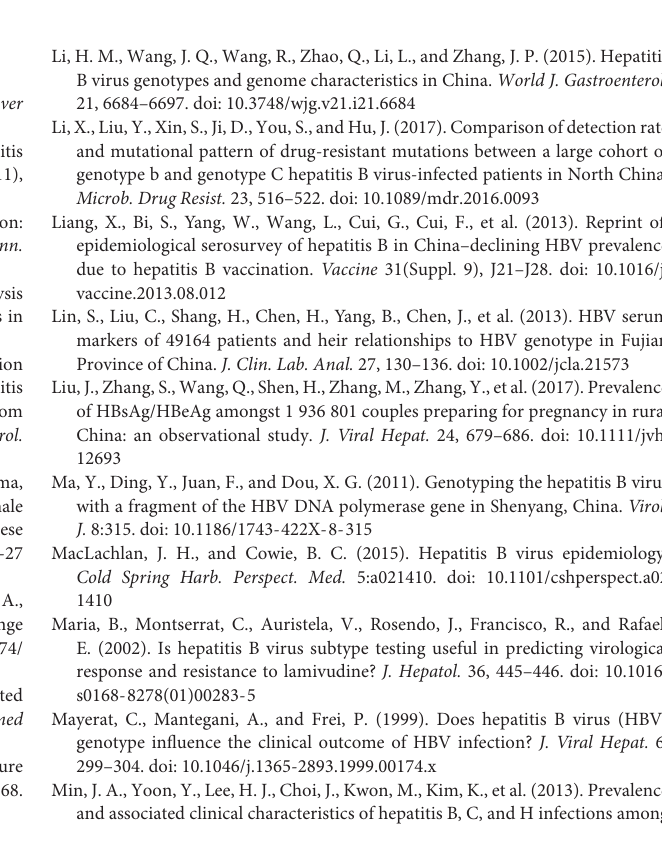
Supplementary Figure 1 | Estimated maximum-likelihood phylogeny for Baisha’s Li ethnic HBV whole-genome sequences. The sequences identified in this study are labeled by “ (cid:117) .” Others are reference